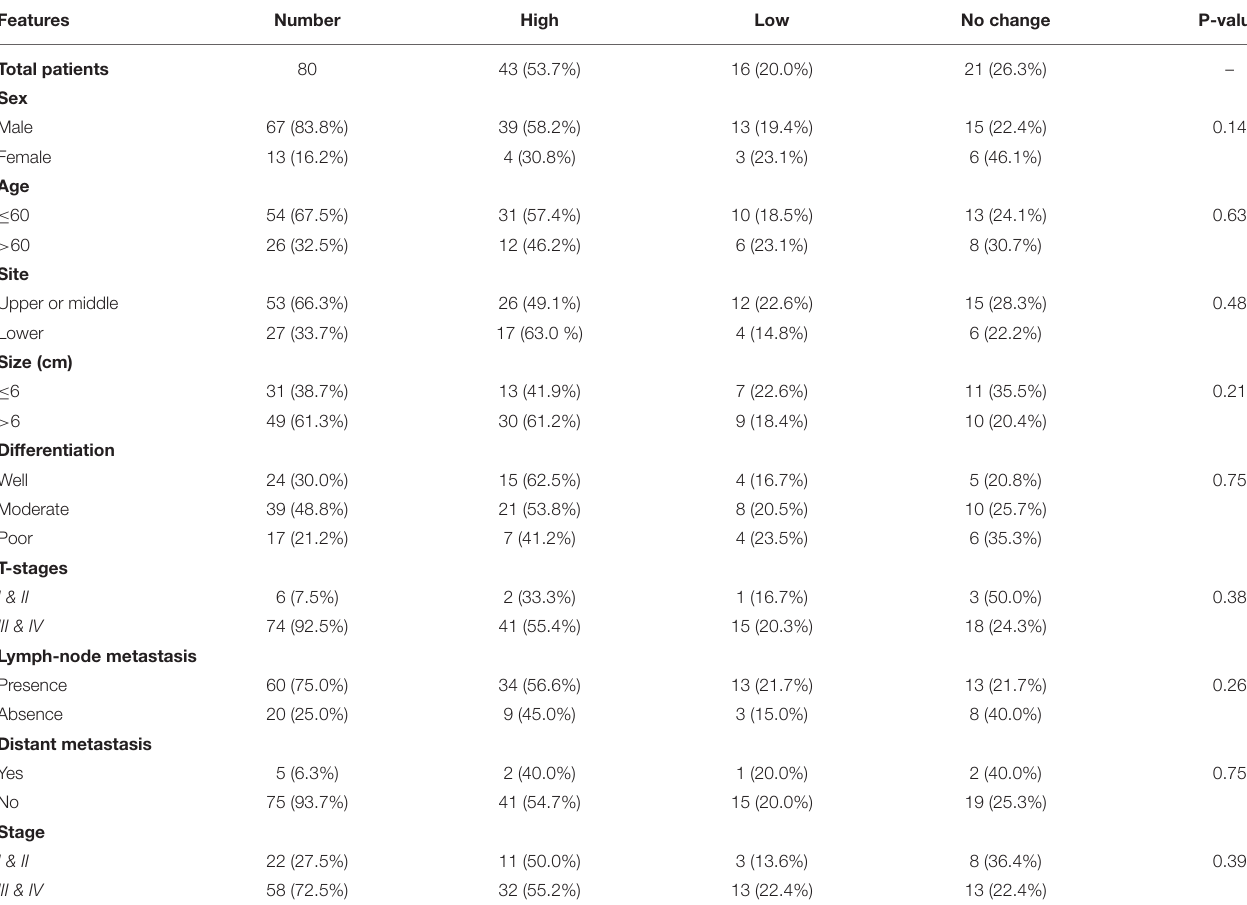
TABLE 4 | Correlation of EPAS1 mRNA expression with clinicopathological features of patients with esophageal squamous cell carcinoma.